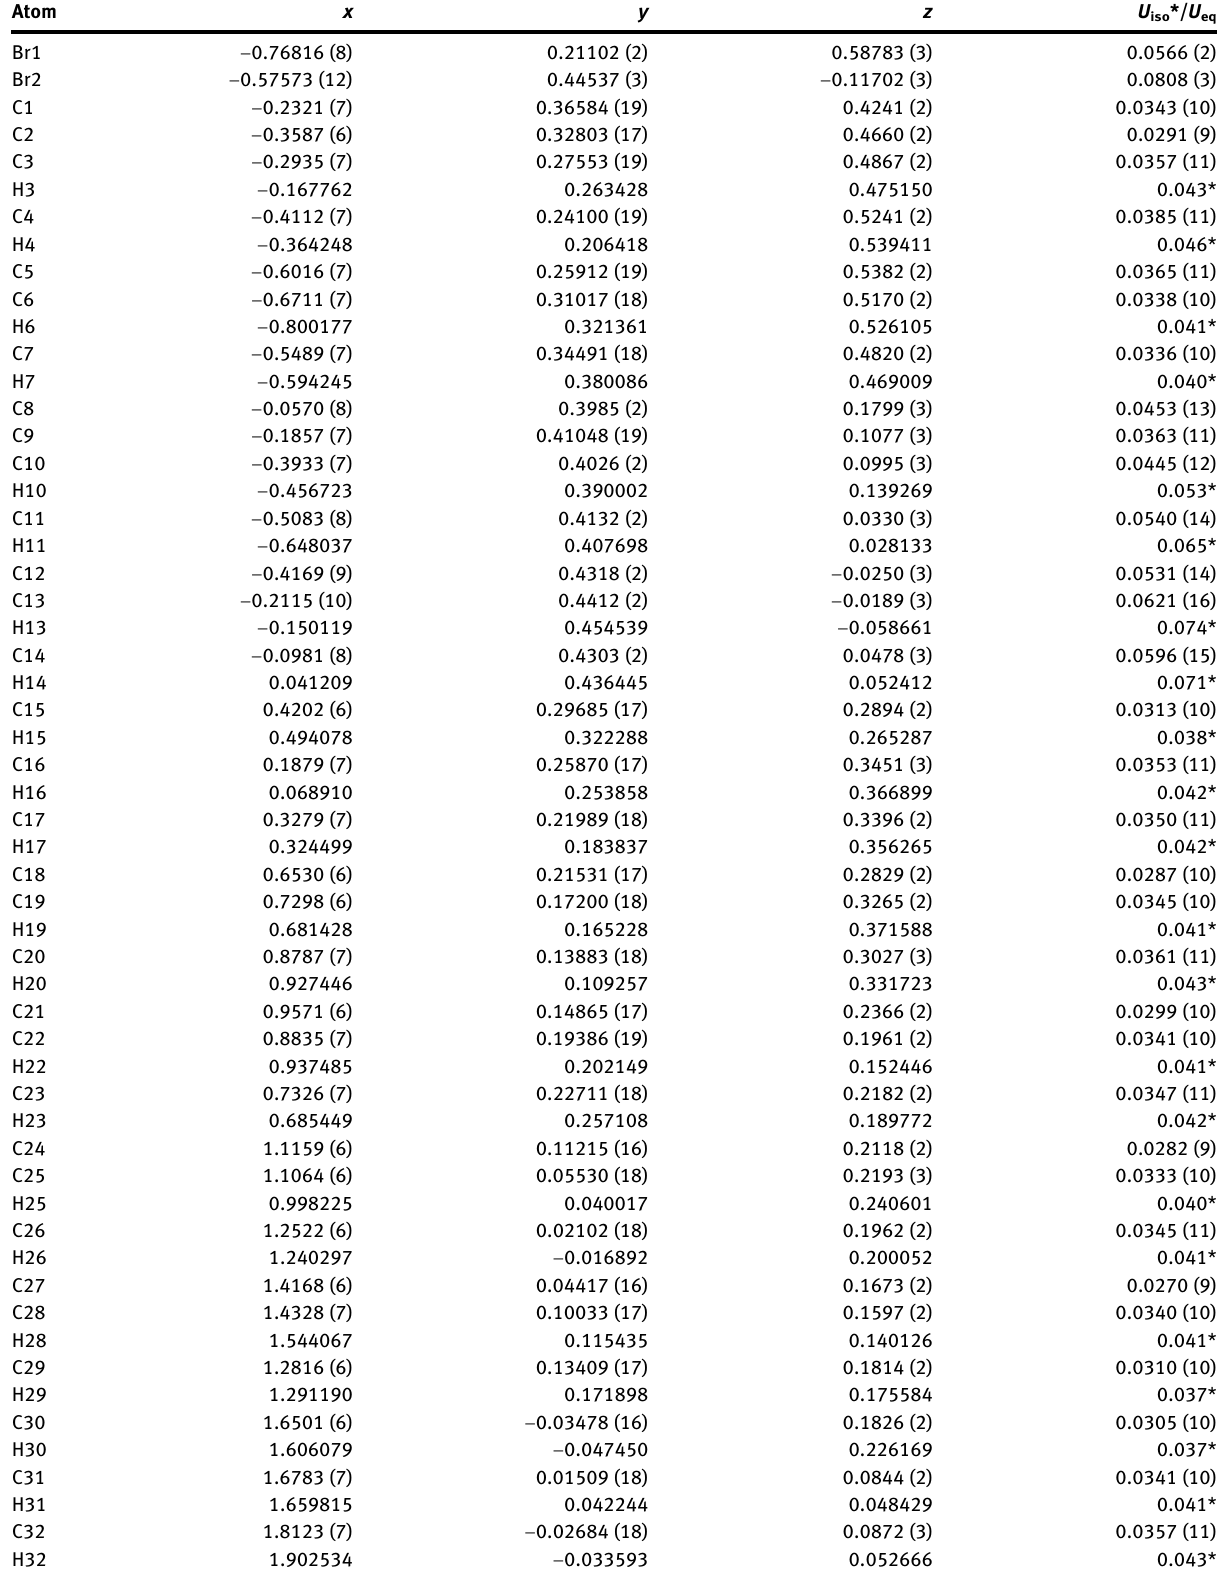
Table  : Fractional atomic coordinates and isotropic or equivalent isotropic displacement parameters (Å 